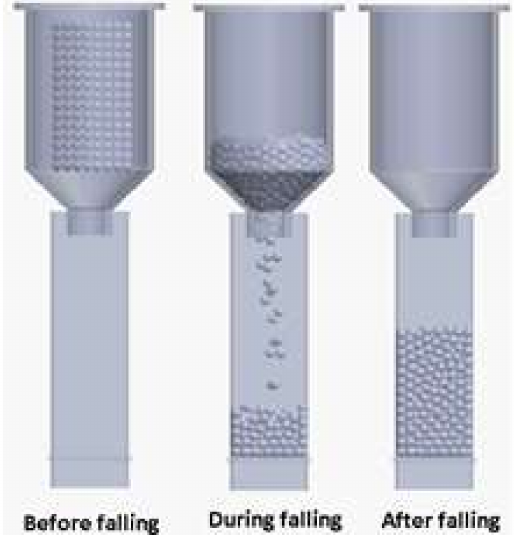
Figure 4. Process of random model creation.